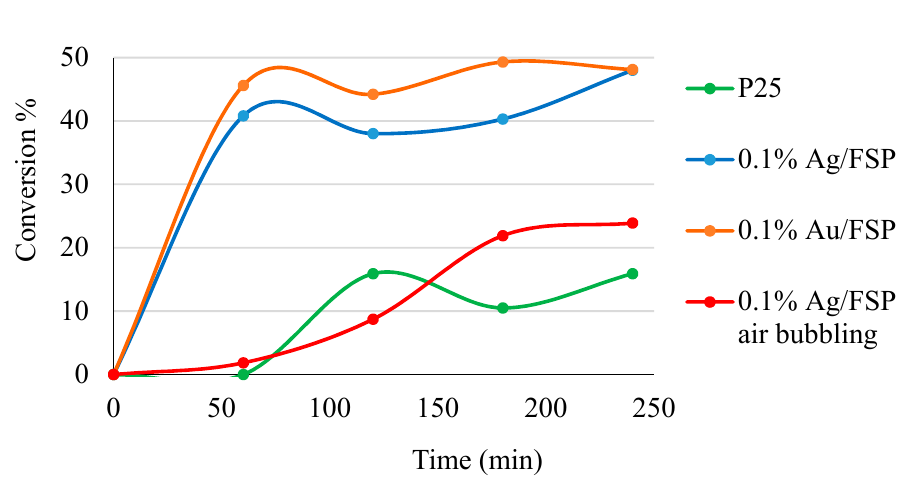
Figure 7. Photo-oxidation of NH 4 with various metal-promoted catalysts under LED lamp irradiation using 0.01 mol of NH 4 Cl, 0.2 g of photocatalyst, pH 5, r.t. and 250 mL of solution.